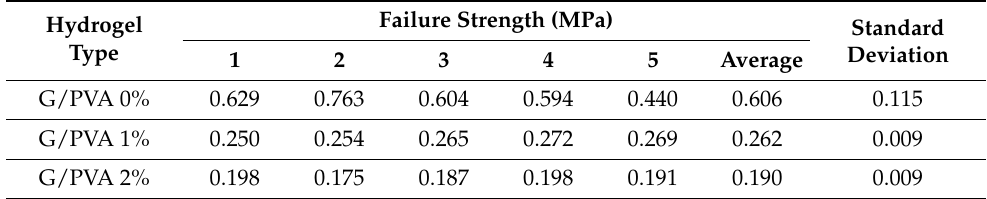
Table 1. Tangent modulus of gelatin and gelatin/PVA-based hydrogels determined at a given strain value for one representative sample of each type of material. Table 2. Compressive strength for gelatin and gelatin/PVA-based